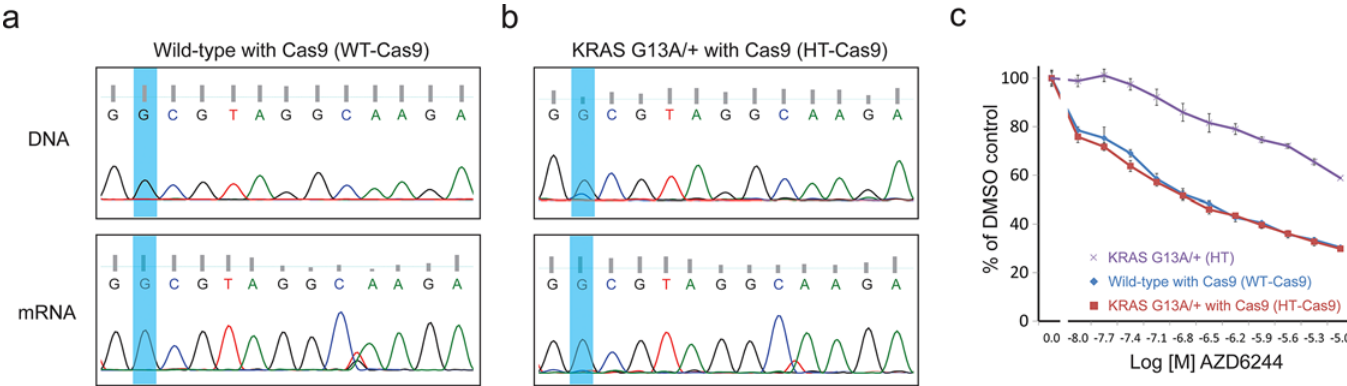
Fig 3. Protospacer Adjacent Mutated Motif-mediated targeting of the KRAS p.G13A mutation in colorectal cancer cells. Genomic DNA or mRNA were prepared from the KRAS WT-Cas9 or HT-Cas9 cells and were used as PCR templates to isolate the cDNA fragments harboring the 13 th codon of the KRAS gene. (a) The Sanger sequencing results of the genomic DNA or mRNA samples from SW48 WT-Cas9 cells. (b) The Sanger sequencing results of the genomic DNA or mRNA samples from SW48 HT-Cas9 cells. (c) The drug response curves of the KRAS HT, WT-Cas9 and HT-Cas9 SW48 cells to the MEK inhibitor AZD6244. The WT-Cas9 and HT-Cas9 cell lines show the same AZD6244 sensitivity.